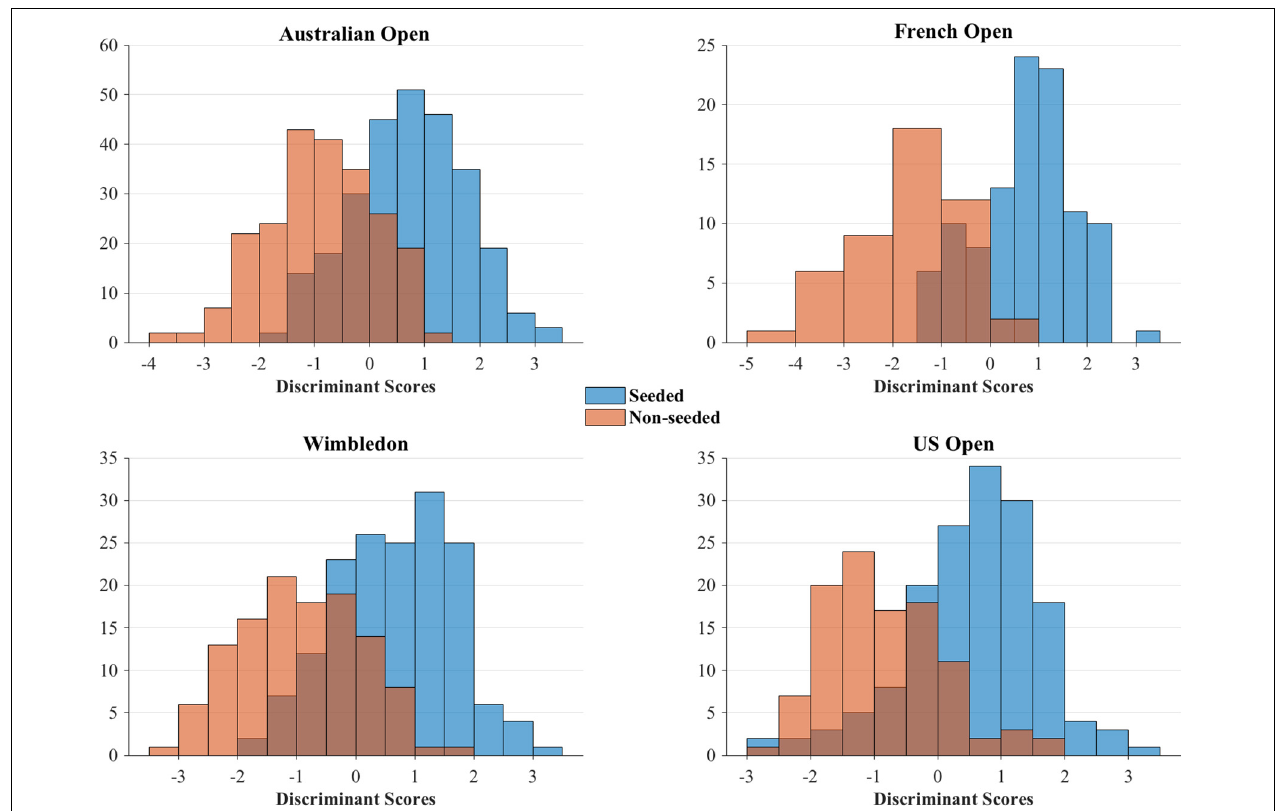
FIGURE 1 | Distribution of discriminant scores for seeded and non-seeded player groups in the four Grand